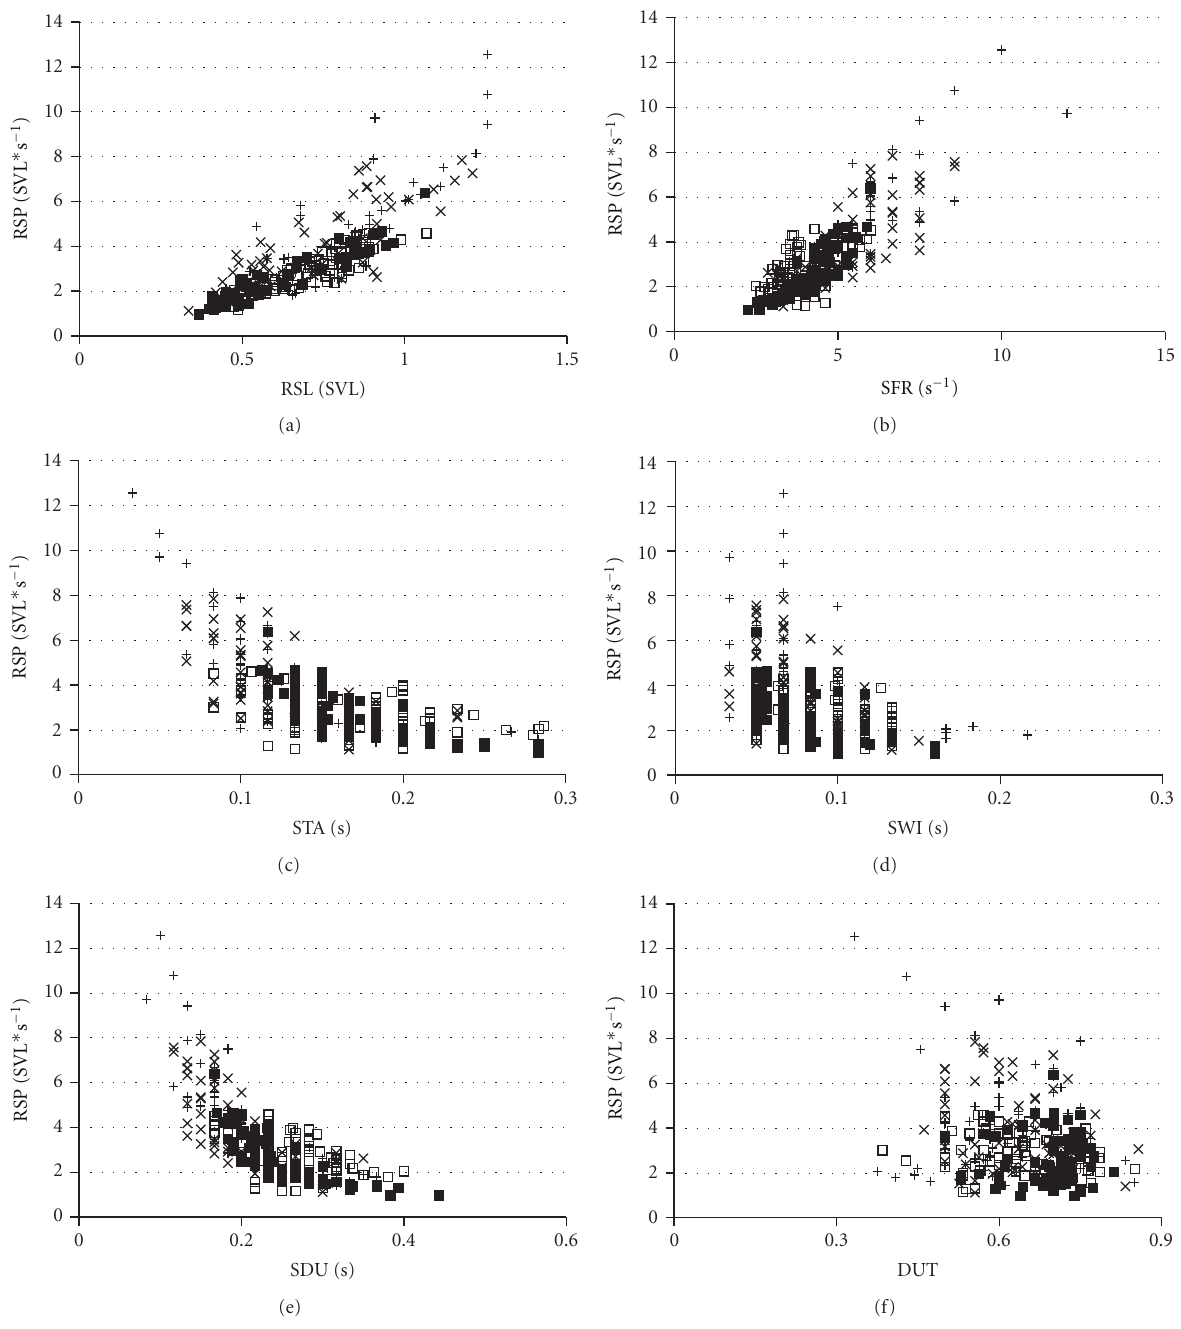
Figure 3: Relative speed plotted against other kinematic parameters of C. taunayi on four substrate types with increasing roughness level: polyethylene plastic (PLAS, black squares), wooden board (WOOD, white squares), glued sand (SAND, “+”), and glued gravel (GRAV, “ × ”). Relative speed (RSP) is measured in snout-vent length units per second. (a) Relative stride length (RSL, in SVL units), (b) stride frequency (SFR, ins − 1 ), (c) stance duration (STA, in s), (d) swing duration (SWI, in s), (e) stride duration (SDU, in s), and (f) duty factor (DUT). All six Spearman correlations are highly significant ( P < 0 .